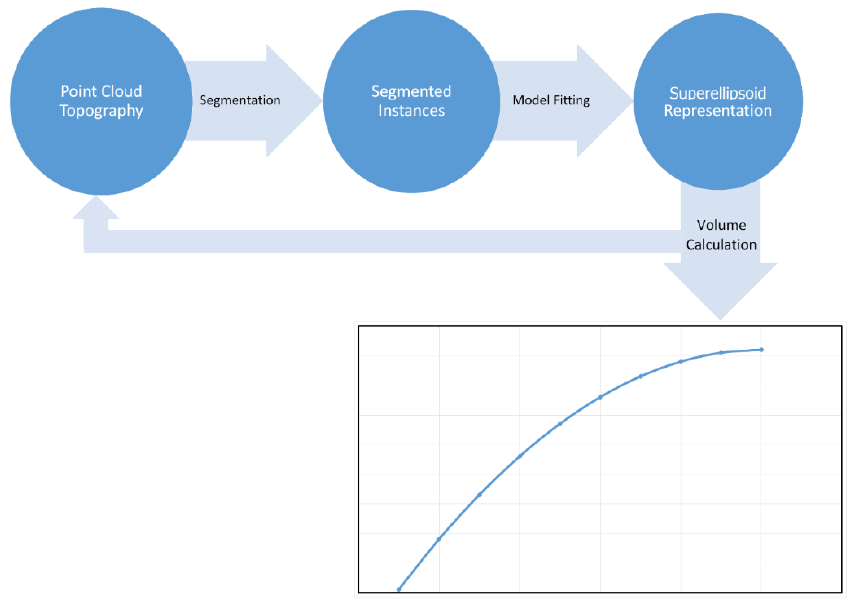
Figure 5. Processing Sequence.